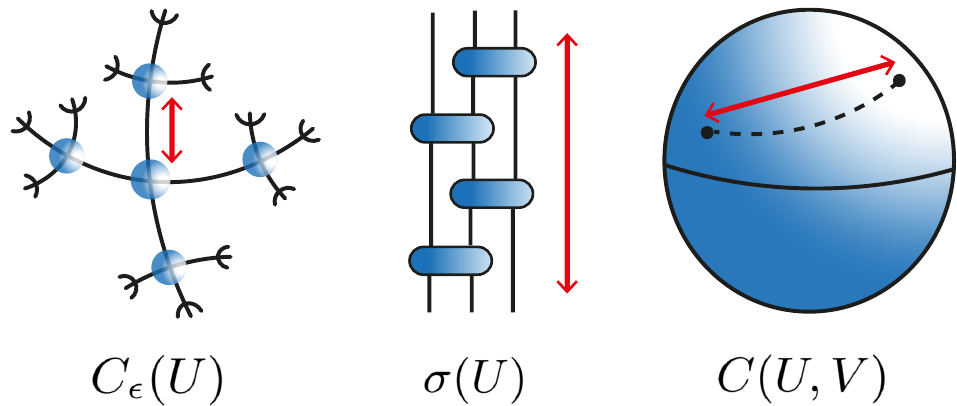
Figure 1 . Left to right: the gate complexity, the circuit depth and the complexity distance define three increasingly smooth notions of quantum complexity on the space of unitary operators.